Question: Provide a one-line summary of what is displayed.
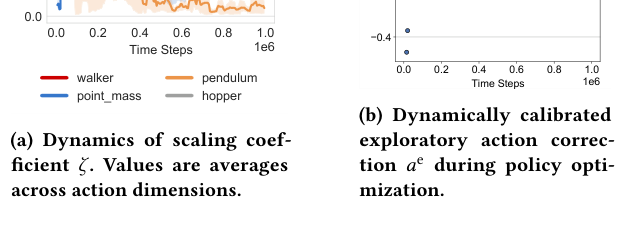
Answer: Visualization of exploratory action scaling.